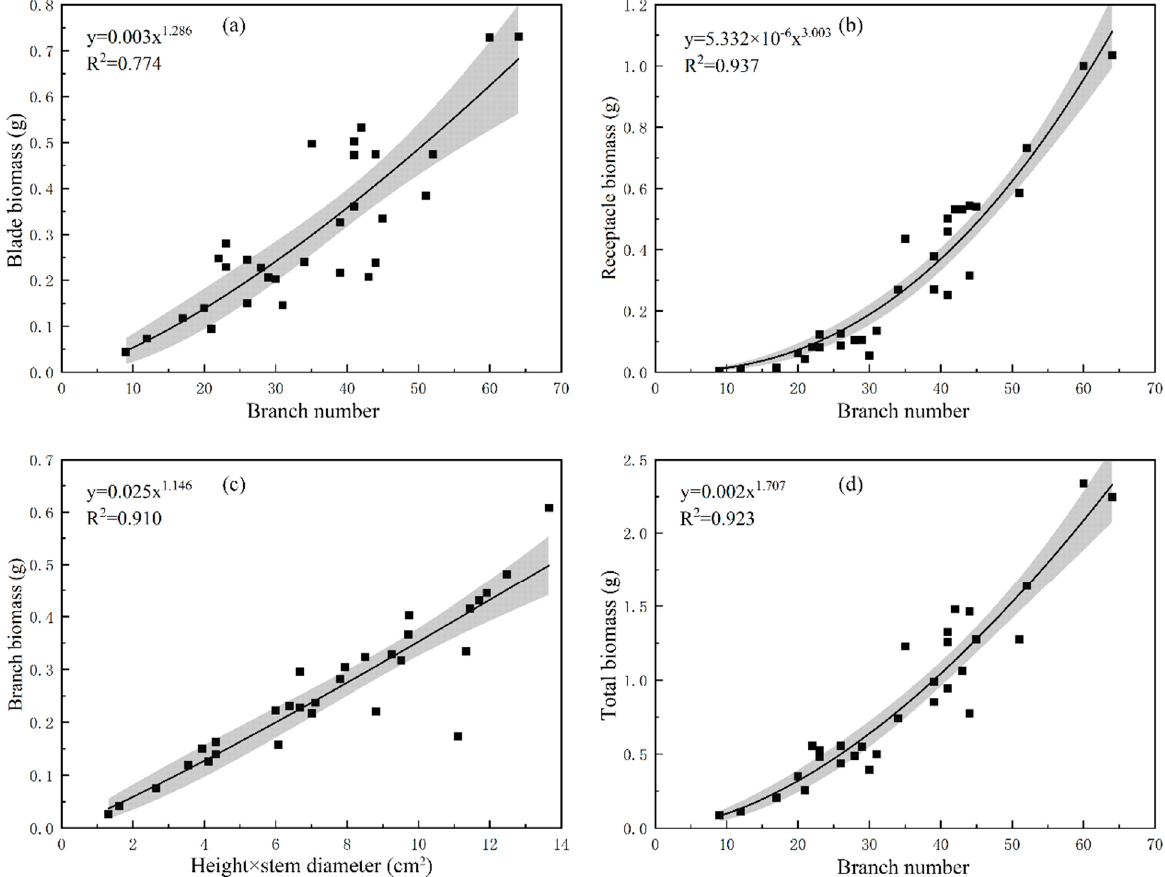
Figure 1. Optimum biomass relationships of Sargassum fusiforme. The black line is the fit curve, and the gray area is the 95% confidence region. ( a – d ) are the optimum biomass relationships of different organs.